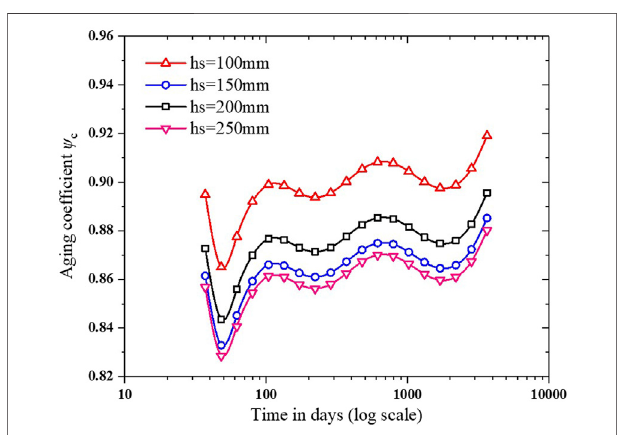
FIGURE 8 | Aging coef fi cient with increasing stud diameter.